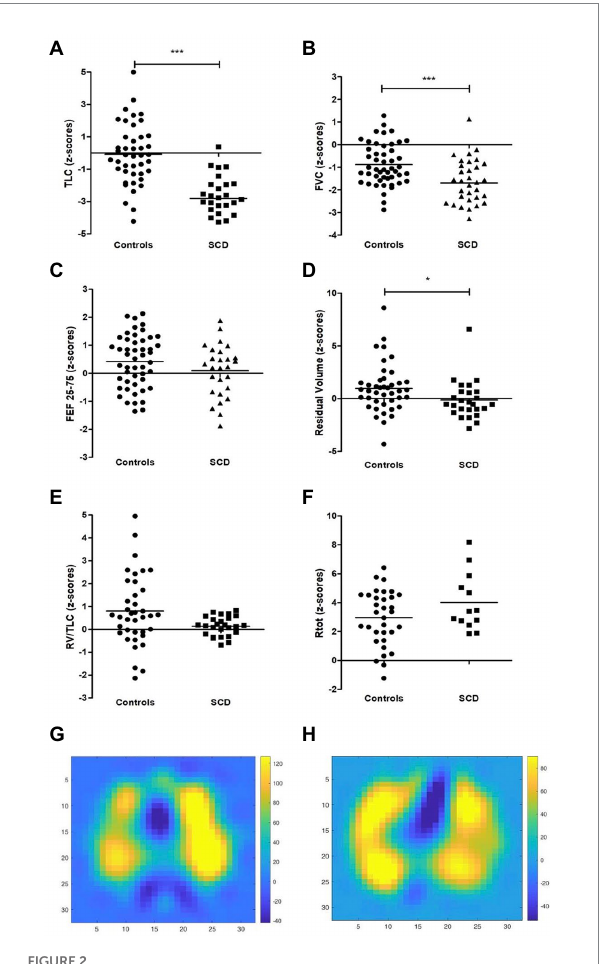
FIGURE 2 Additional lung function parameters of SCD patients and controls and examples of EIT difference images (A) TLC (z-scores), (B) FVC (z-scores), (C) FEF25-75 (z-scores), (D) RV (z-scores), (E) RV/TLC (z-scores). (F) Rtot (z-scores), (G) difference image of control patient and (H) SCD patient at forced expiration in 32 × 32 pixel images over the course of the examination with the color scale set as follows: the minimum value was set to 75% of the minimum value of the difference image and the maximum value was set to 75% of the maximum value of the difference image. Yellow color indicates higher differences and thus more ventilation.